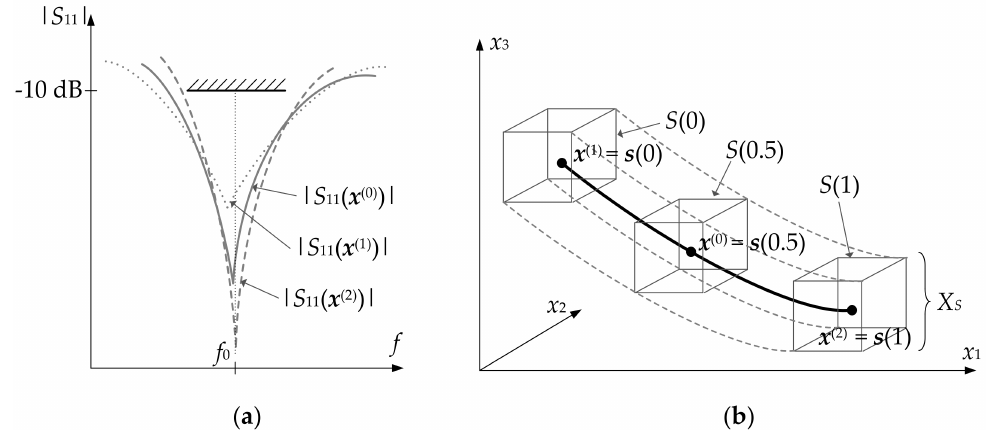
Figure 4. Yield optimization of multi-band antennas using performance-driven surrogates: ( a ) re- flection responses of an exemplary narrow-band antenna at the nominal design x (0) , maximum bandwidth design x (1) , and best matching (at f 0 ) design x (2) . These designs determine the directions of the most significant response changes (from the point of view of the target operating bandwidth); ( b ) The reference designs x (0) through x (2) form a path (a parameterized curve s ( t )). The union of intervals S (t) (cf. (15)) form the surrogate model domain X S